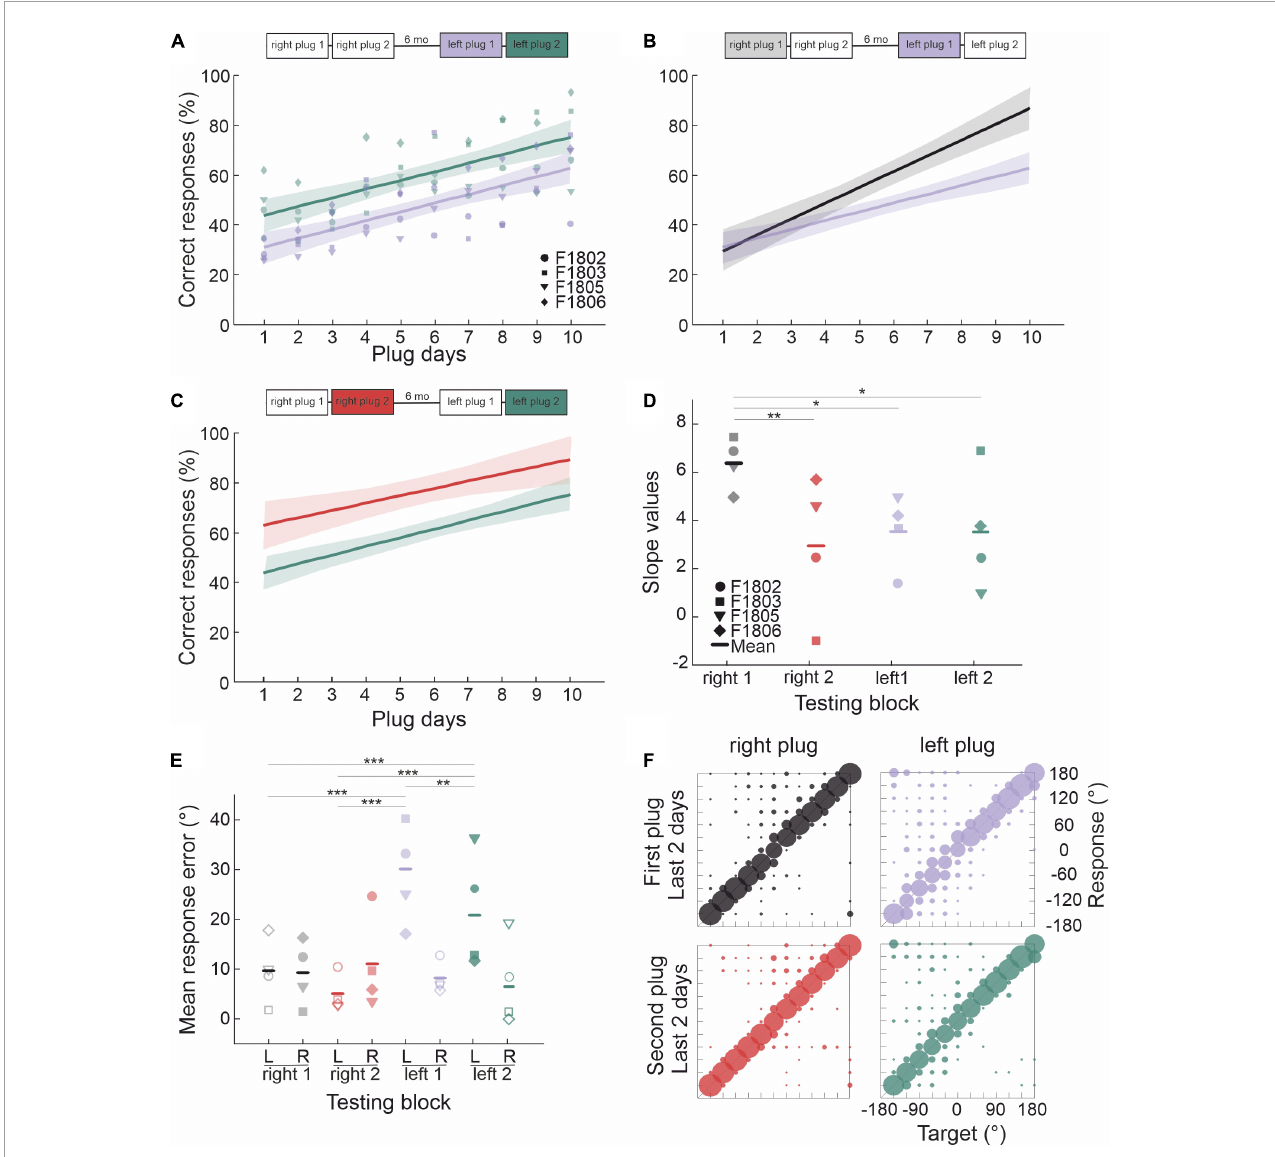
FIGURE6 Effect of occluding the other ear following adaptation to unilateral conductive hearing loss. (A) Regression lines (shaded areas indicate 95% confidence intervals) and individual animal scores during the first (left plug 1, purple line and symbols) and second (left plug 2, green line and symbols) periods of left ear occlusion, which were separated by 7 days of normal binaural hearing. Unlike the right plug 1 and right plug 2 runs ( Figure 4A ) previously experienced by these animals, the slopes of the linear fits to these data were very similar. (B) Comparison of the regression lines for the right plug 1 (black/gray) and left plug 1 (purple) runs. Although the ferrets performed at the same level when each ear was first plugged, much less adaptation was seen when the hearing loss was experienced in the left ear following adaptation to right ear occlusion. (C) Comparison of the regression lines for the right plug 2 (red) and left plug 2 (green) runs. The slopes are very similar, but the difference in intercepts indicates less overall improvement in localization accuracy when the left ear was occluded. (D) Individual animal and mean regression slopes for the fits shown in panels (A–C) . (E) Mean response error magnitude in the final 2 days of each of these periods of monaural occlusion (right plug 1 and 2, left plug 1 and 2). Errors are shown separately for target locations ipsilateral (filled symbols) and contralateral (open symbols) to the side of the earplug. Midline locations (0 ◦ and 180 ◦ ) were not included in this analysis. Asterisks represent statistical significance of paired comparisons (* p < 0.05, ** p < 0.01, and *** p < 0.001). (F) Response probabilities versus target location for the final 2 days of the first right and left (top row) and the second right and left (bottom row) periods of monaural occlusion.